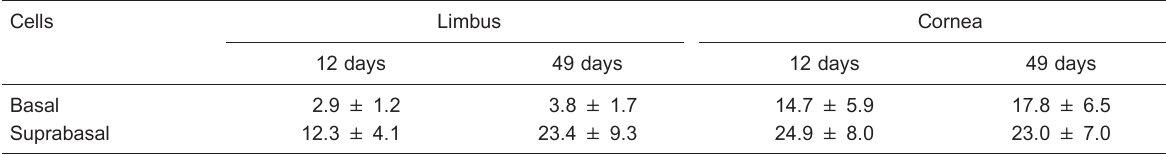
Table 1. Labeling indices for the epithelium covering the limbus and the cornea of non-stimulated rabbits injected 3 times with [ 3 H]-TdR, at intervals of 4 days, and killed at 12 and 49 days after the first injection.